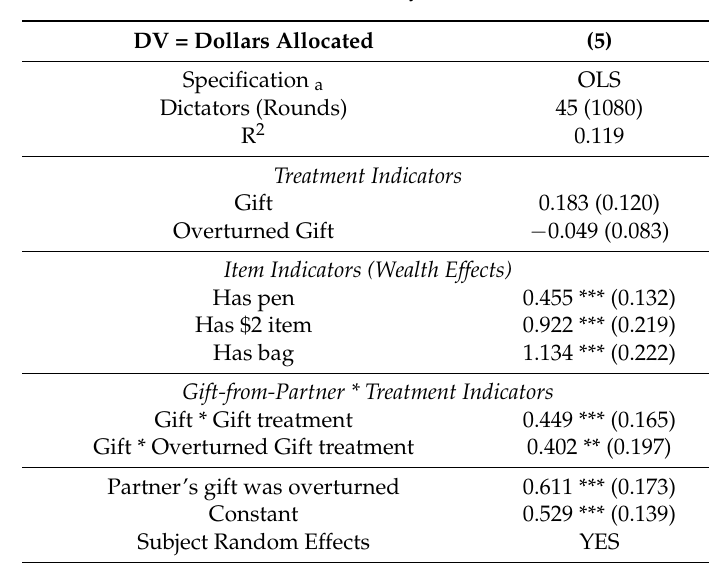
Table 2. Allocation by